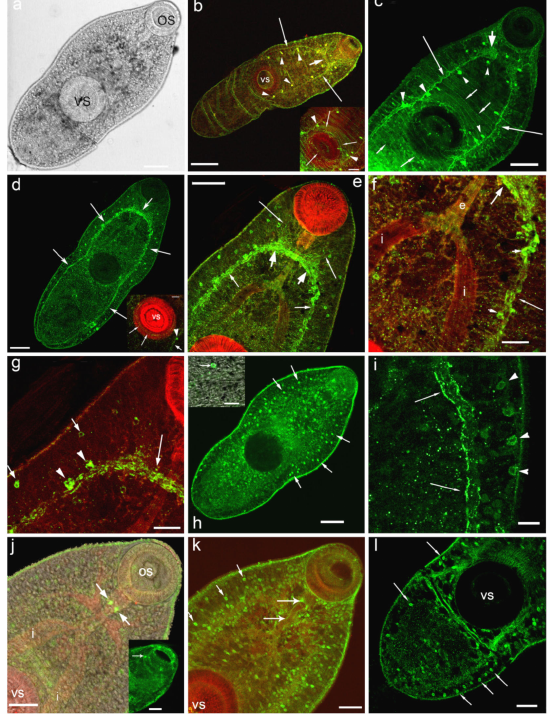
Figure 1. Immunoreactivity to serotonin ( b , c ) and 5-HT 7 serotonin receptor ( d – l ) in metacercariae larvae of Opisthorchis felineus (in green) and histochemical staining of muscles with phalloidin (in red). ( a )—overview of metacercariae of O. felineus , transmission light microscopy, whole mount; ( b )—5-HT-IR (green) in the central nervous system—the brain ganglia and brain commissure (thick arrow), in the ventral nerve cord (long thin arrows), the serotonergic neurons of the nerve cords are indicated by arrowheads, inset : the 5-HT-IR cells (arrowheads) and fibres innervating the ventral sucker (thin arrows), running from the ventral nerve cords; TRITC-phalloidin staining for muscles are shown in red; ( c )—anti-serotonin staining in cephalic ganglion (thick arrow), ventral nerve cords (long arrows), in transversal commissures connecting the nerve cords (short arrows), serotonergic neurons in head ganglion and in the nerve cords are indicated by arrowheads; ( d )—anti-serotonin receptor 5-HT 7 -IR (green) in the longitudinal nerve cords (long thin arrow), in the brain ganglia and brain commissure (short arrow), inset: 5-HT 7 -IR in the ventral sucker (long arrows), in the nerve cord at the level of ventral sucker (short arrow) and in the round body (arrowhead); ( e )—5-HT 7 -IR in brain ganglia and brain commissure (thick arrows), in the major nerve cords (thin short arrows) and in the anterior nerves (long arrows); the round structures scattered through the body are also visible; ( f )—a higher magnification, 5-HTR 7 -IR in the brain ganglion (thick arrow) and in the lateral nerve cords (thin long arrows), in neurons of the nerve cord (short arrows); ( g )—5-HT 7 -IR in brain commissure (long arrow), in the neurons within the major nerve cords (arrowheads) and in the round structures, probably the gland cells or the other unidentified cells along the lateral body side (short arrows); ( h )—5-HT 7 -IR in the round structures (the secretor gland cells or the other unidentified cells) scattered throughout the worm body (long arrows), inset: the larger magnification of the round structure (arrow); ( i )—5-HTR 7 along the major nerve cords (arrows) and in the round structures (arrowheads), the posterior body region; ( j )—5-HT 7 -IR in two serotonergic neurons located near pharynx (arrows), inset: 5-HT 7 -IR in the structures, located in the structures (the sensory papillae) located in the oral sucker (arrow); ( k )—5-HT 7 -IR in serotonergic neurons and fibres located near pharynx and esophagus (long arrows), the round structures scattered throughout the worm body are visible (short arrows); ( l )—a row of 5-HT 7 immunopositive structures in posterior region of the worm (long arrows) and near the ventral sucker. Scale bars: ( a , c – e , h )—50 µ m; ( b )—100 µ m; ( g , f ), inset on ( d )—20 µ m; ( i ), inset on ( h )—10 µ m, ( j – l ); inset on ( g )—30 µ m. Abbreviations: e—esophagus, i—intestine branches, os—oral sucker, vs—ventral